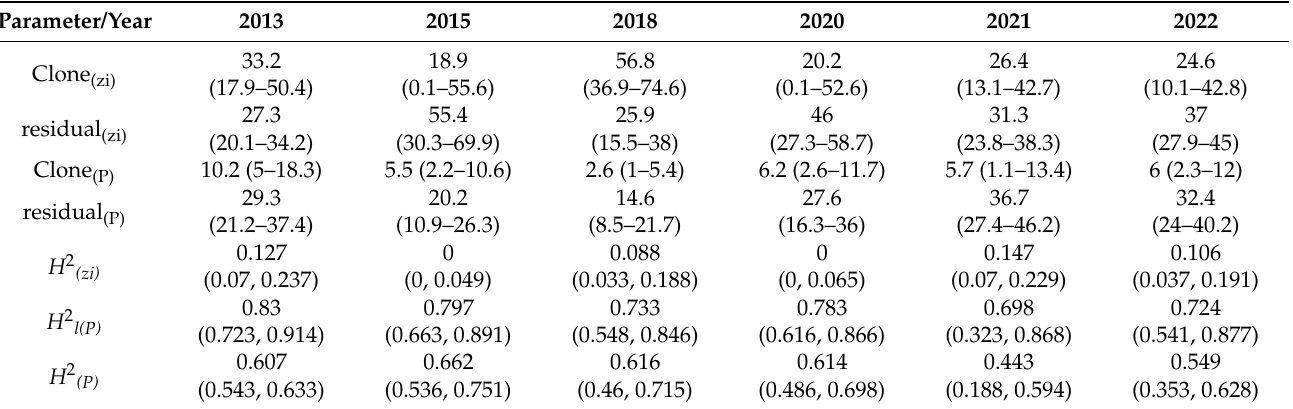
Figure 1. Variance explained by random effects in the multi-year model, Poisson (P), and zero-inflated (zi) components. Posterior means (points), 99%, and 95% credible intervals (lines, respective blocks) are in latent scale. Table 3. Proportion of variance explained by random effects and heritability in single-year models. Estimates are reported as posterior mode (95% credible interval, proportion of variance from latent scale, heritability in both latent ( H 2 l(P) ), and data scale ( H 2 (zi) , H 2 (P) ), for Poisson (P) and zero-inflated (zi) component of the